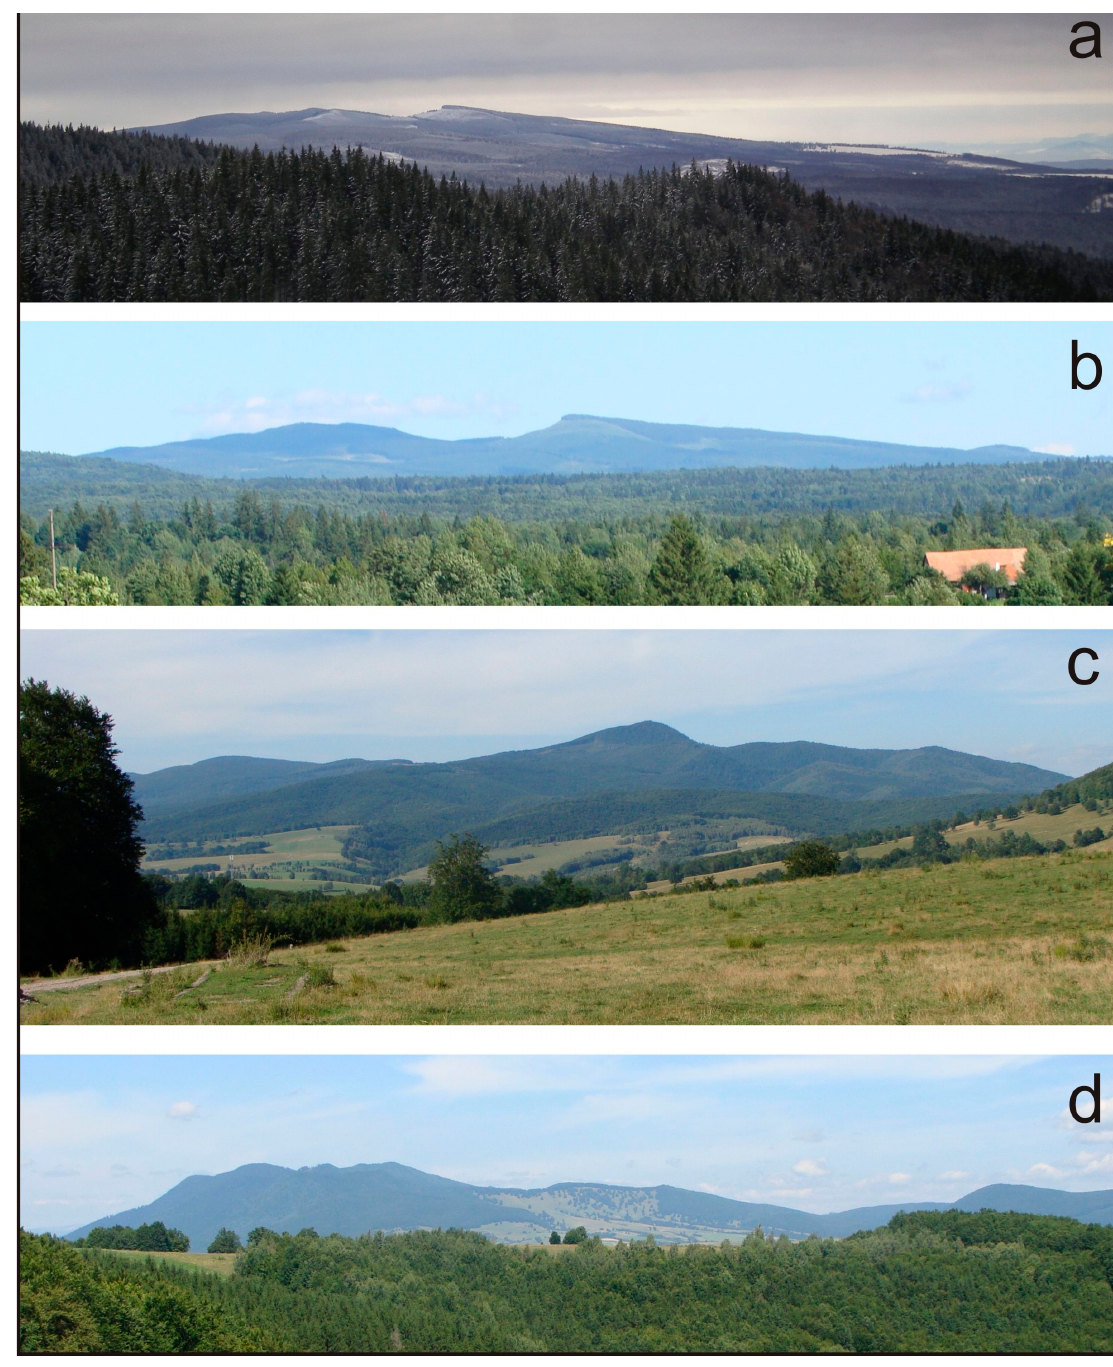
Figure 10. Individual South Harghita volcanoes (from top to bottom): ( a ) Luci-Lazu as seen from the North (Harghita-B ă i), ( b ) Cucu as seen from the North (Tolvaio ș Pass), ( c ) Pili ș ca as seen from the South (Ozunca-Bai), ( d ) Ciomadul as seen from the South (Micfal ă u village). Note the topographic expression of the summit crater areas of Luci-Lazu ( a ) and Cucu ( b ) volcanoes. The shield-like lower part of Pilis ca volcano is topped by a steep-sided lava dome ( c ). The isolated peripheral Dealul Mare , dome is visible in the right-side of the picture as separated from the central cluster of the Ciomadul dome complex ( d ). (Photos: Alexandru Szak á